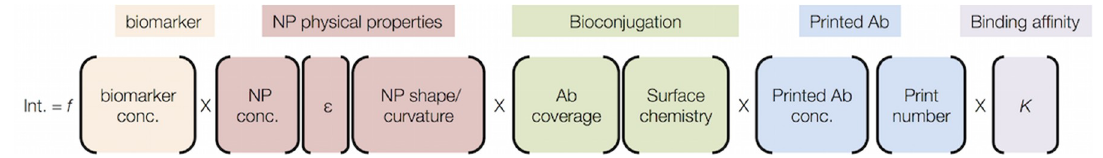
Figure 8. Factors influencing the test line intensity in paper‐based assays. From Reference [36] .